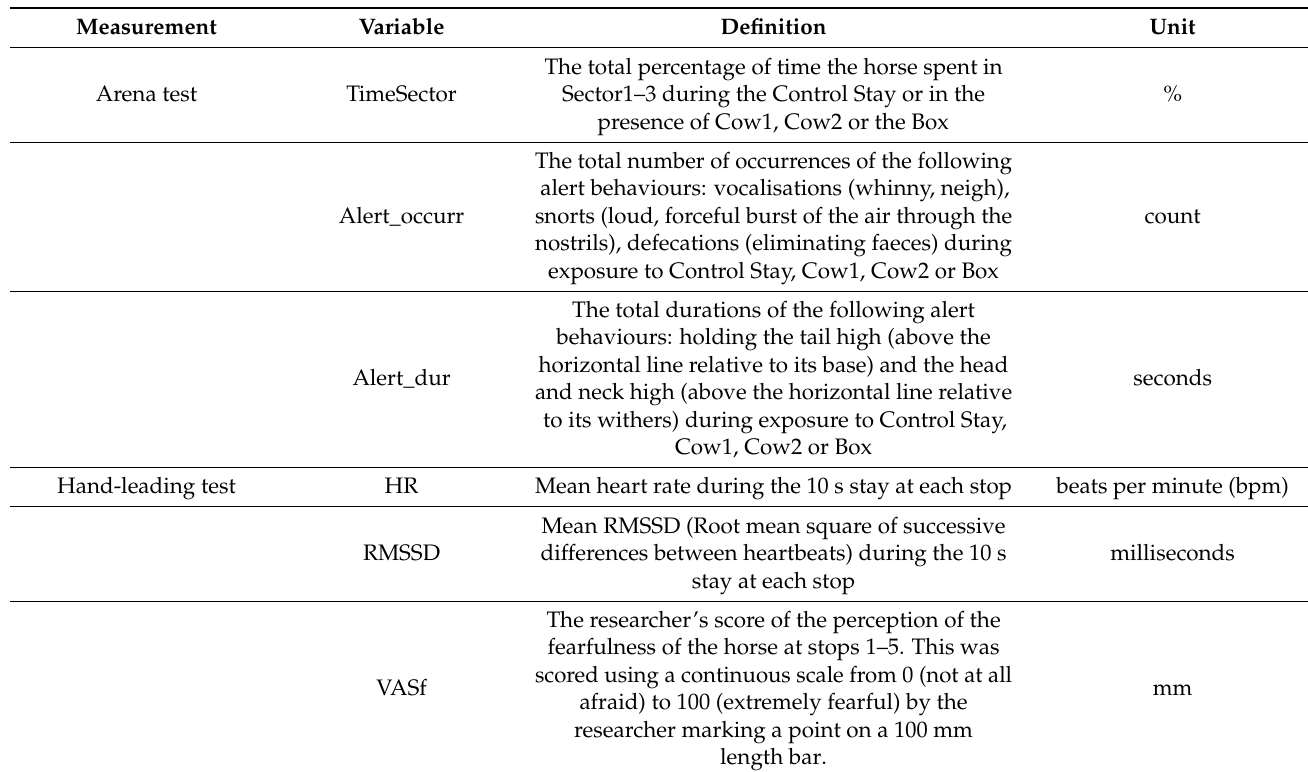
Table 1. The variables measured in